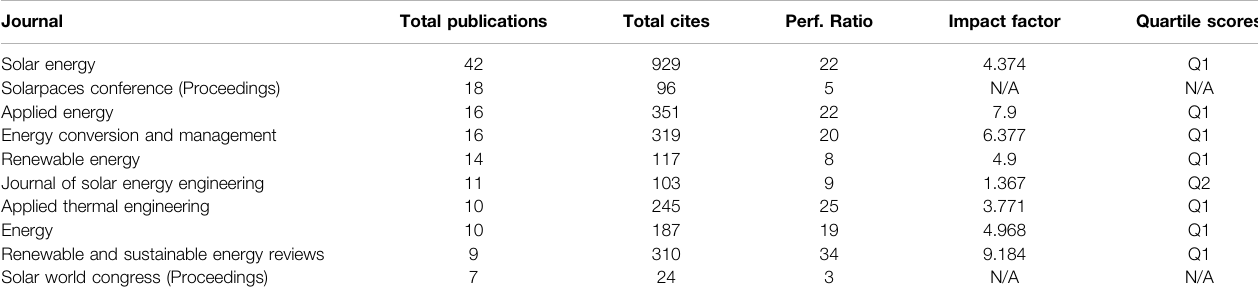
TABLE 18 | Top 10 journals in the Fresnel fi